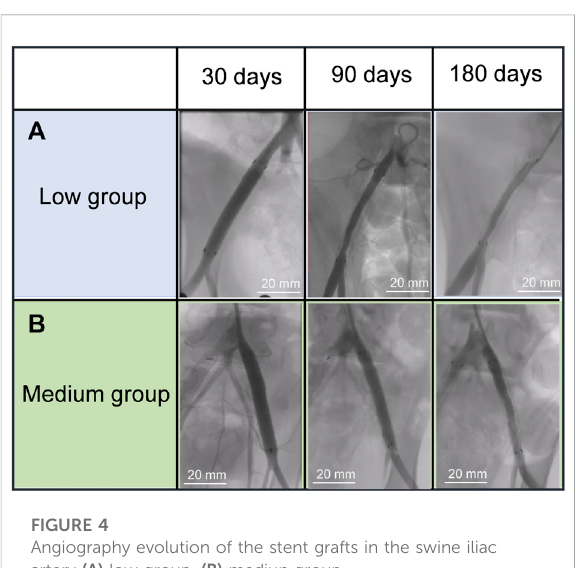
FIGURE 4 Angiography evolution of the stent grafts in the swine iliac artery (A) low group, (B) mediun